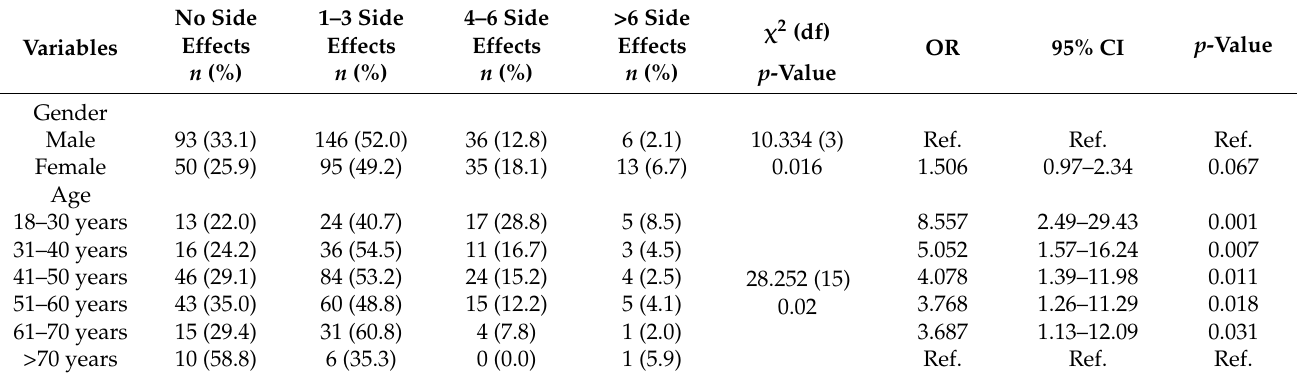
Table 2. Association of the number of side effects with different demographic